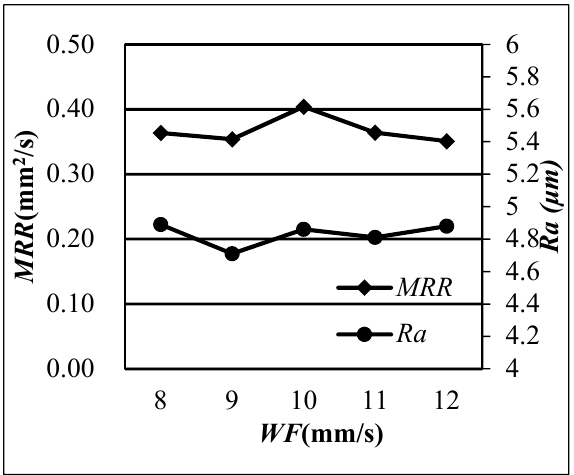
Figure 7. The effect of WF on MRR and SR.